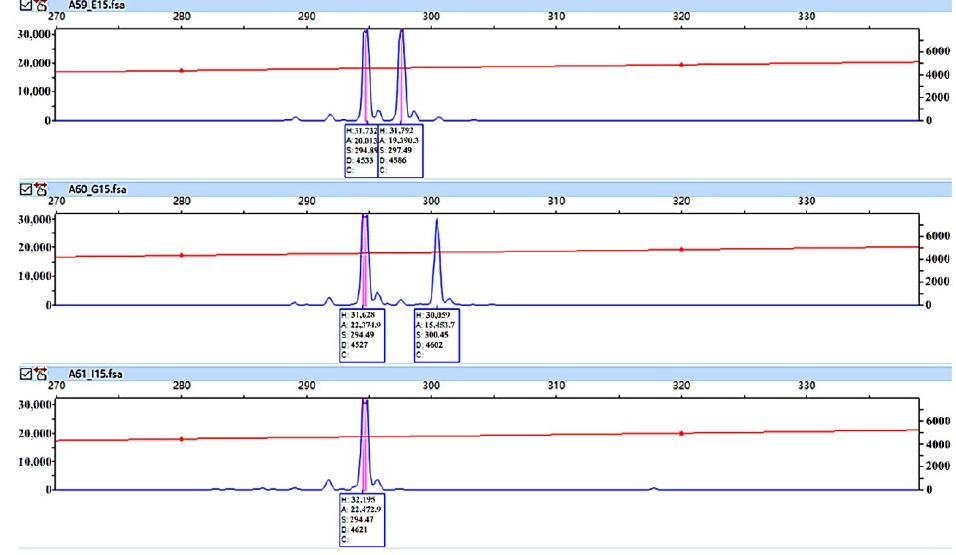
Figure 2. Amplification map of the SSR marker E-SSR58. Table 3. Polymorphism information of the 10 SSR loci.